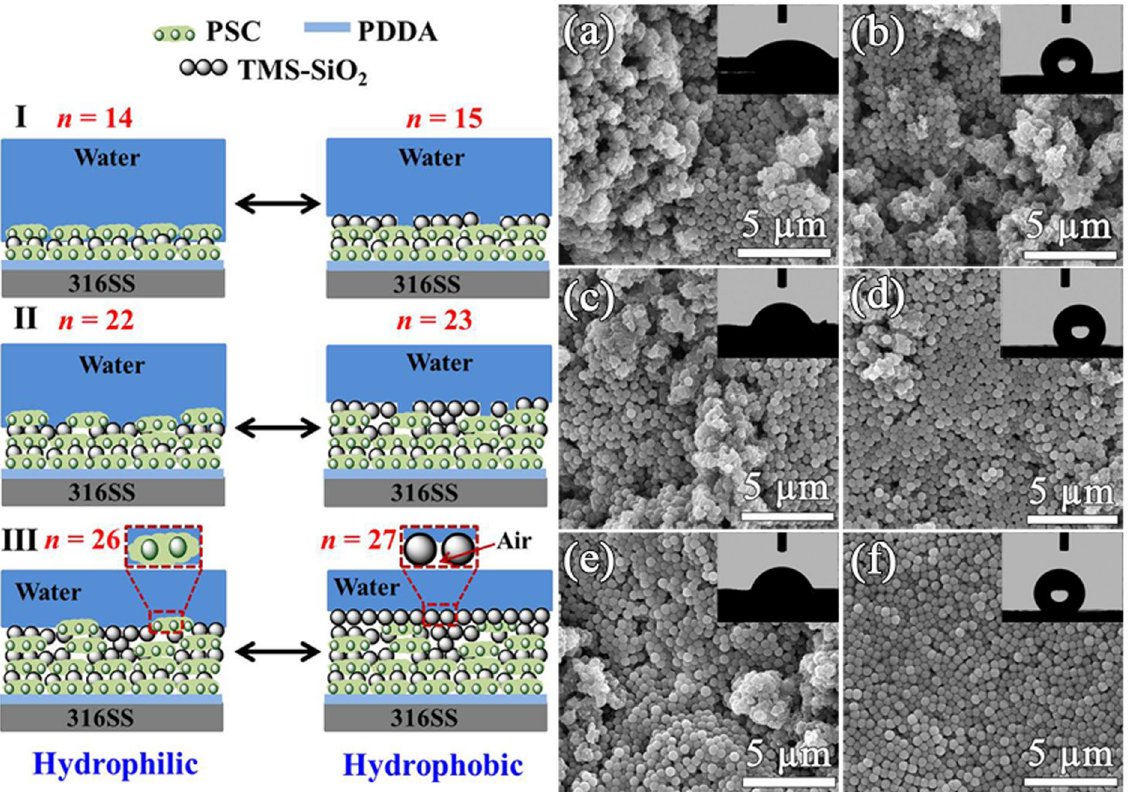
Figure 5. Schematic illustrations of the possible PSC/TMS-SiO 2 coating-liquid contact modes in regimes I–III with surface wetting reversibility between hydrophilic ( n = 14, 22, 26) and hydrophobic ( n = 15, 23, 27) states. SEM image of PSC/TMS-SiO 2 coating with their CA image as inset at odd n ( a , c , e ) and even n ( b , d , f